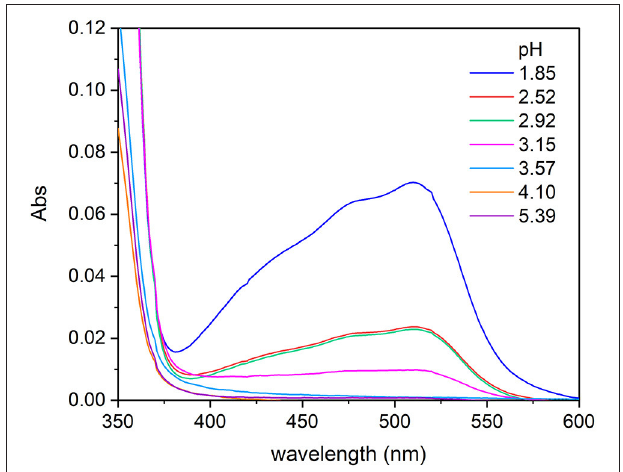
FIGURE 1 | Absorption spectra recorded on solutions of Fe(III)/1,10-phenantroline/TA with concentrations 2.0 × 10 − 5 , 6.5 × 10 − 5 , and 4.0 × 10 − 5 mol L − 1 , respectively, at different pH, after 2h from the preparation.